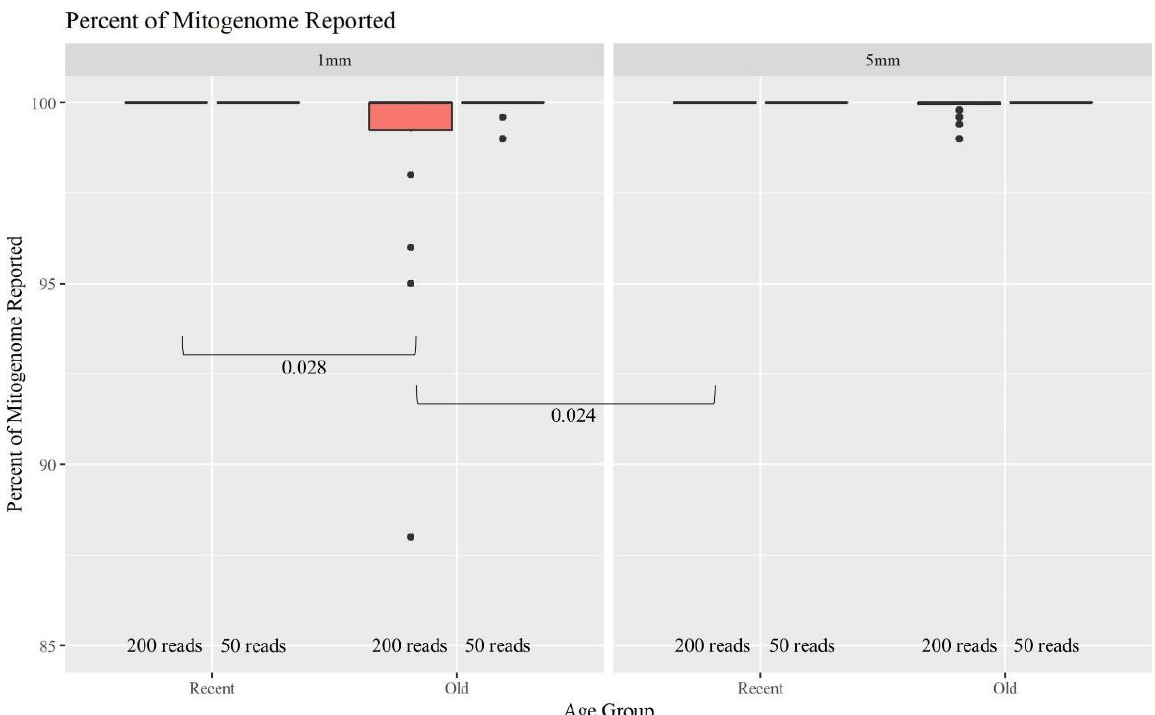
Figure 8. Boxplots for the comparison of the percent of the whole mitogenome reported for each age group and length at 200 reads and 50 reads (n = 74; n R = 26, n O = 48). The line on the boxplots represents the median. Brackets show comparisons with significant p -values ( p < 0.05).